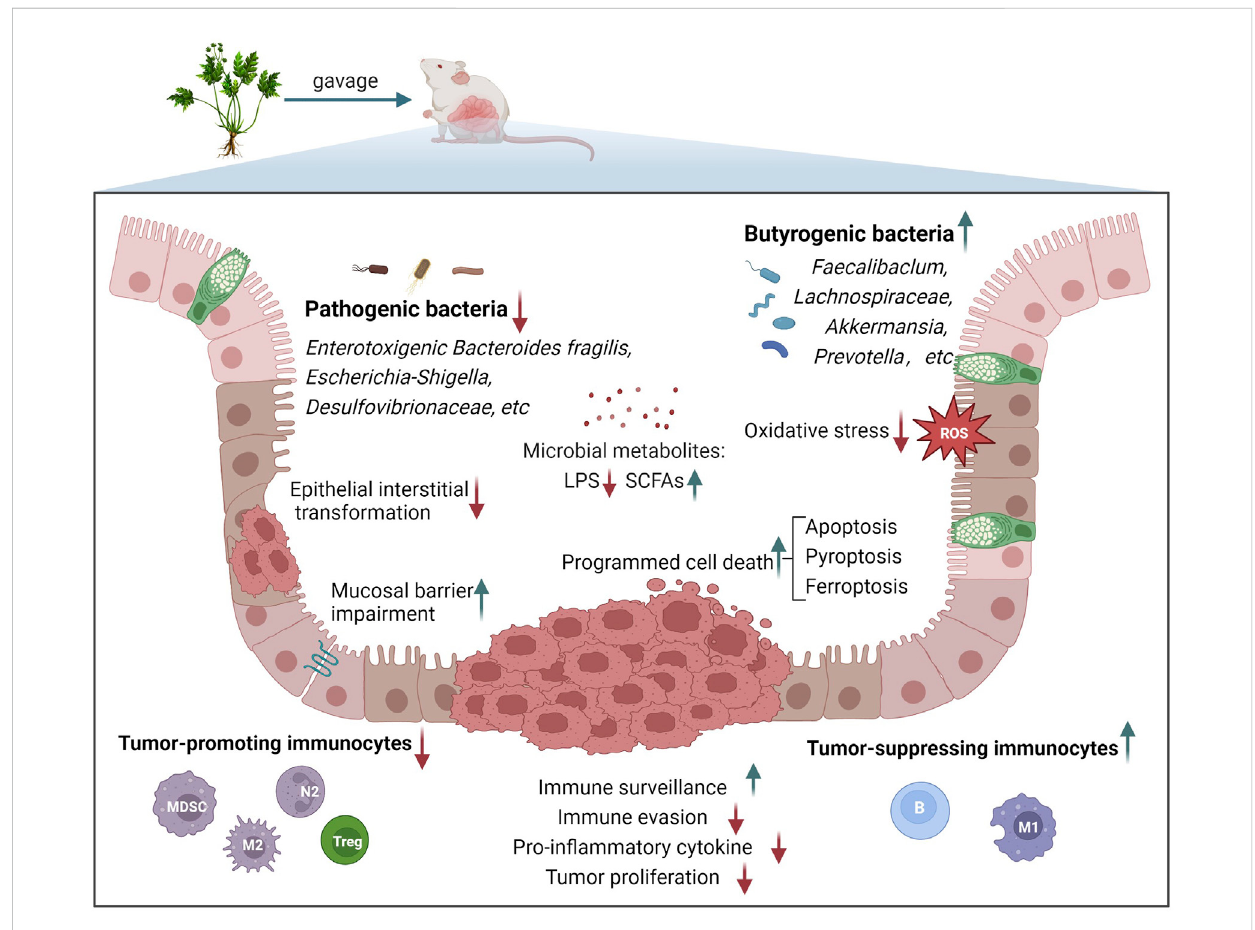
Main biological processes involved in the treatment of CAC with TCM